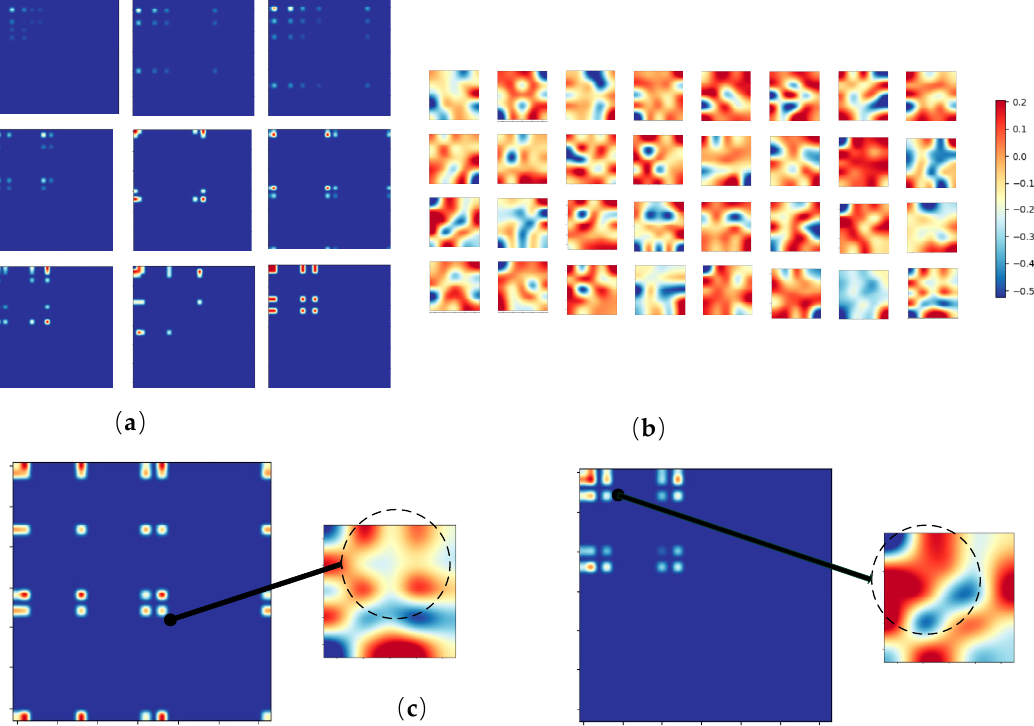
Figure 7. Feature extraction and analysis. The color in the figures indicates the value of points, as shown in the color bar. ( a ) visualization of two-dimensional OFM descriptors; ( b ) visualization of filters of the first convolutional layer; ( c ) the relation of the CNN filters and original two-dimensional OFM matrices.